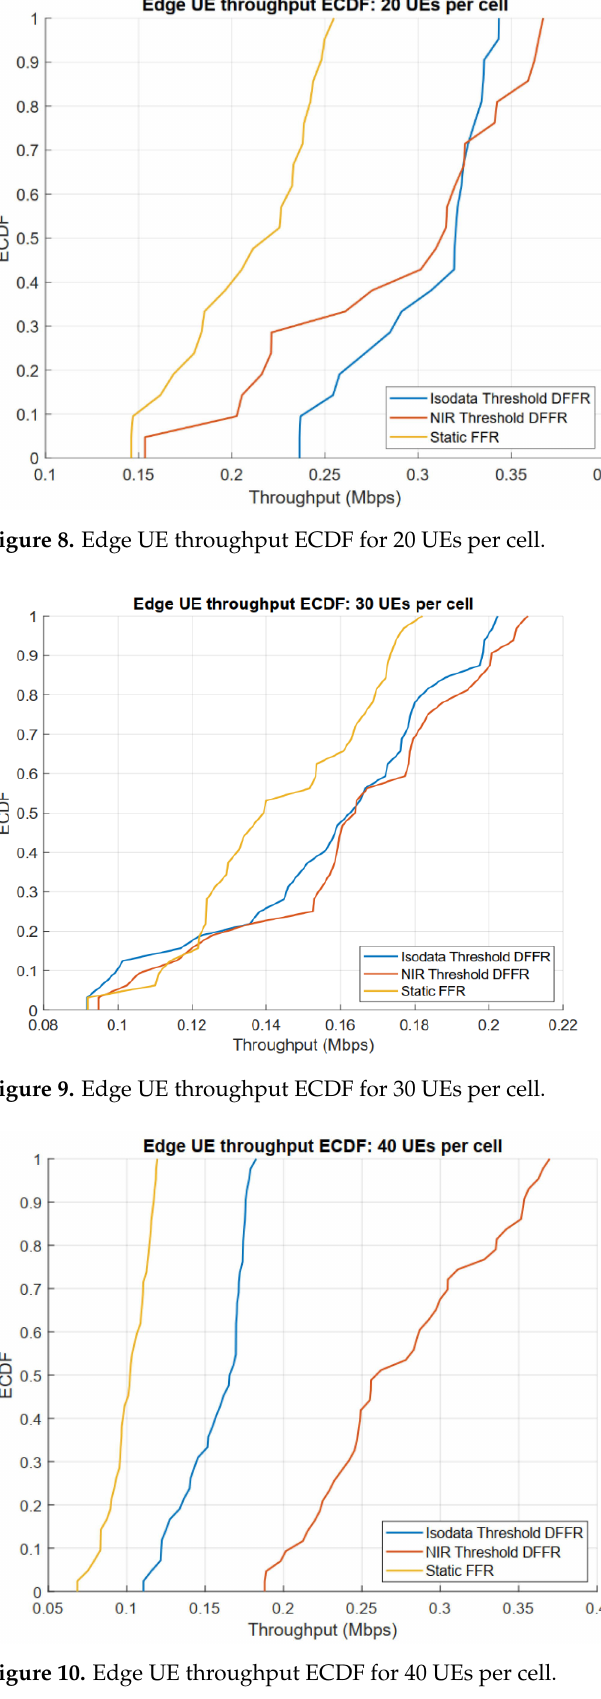
Figure 11. Edge UE throughput ECDF for 50 UEs per cell.